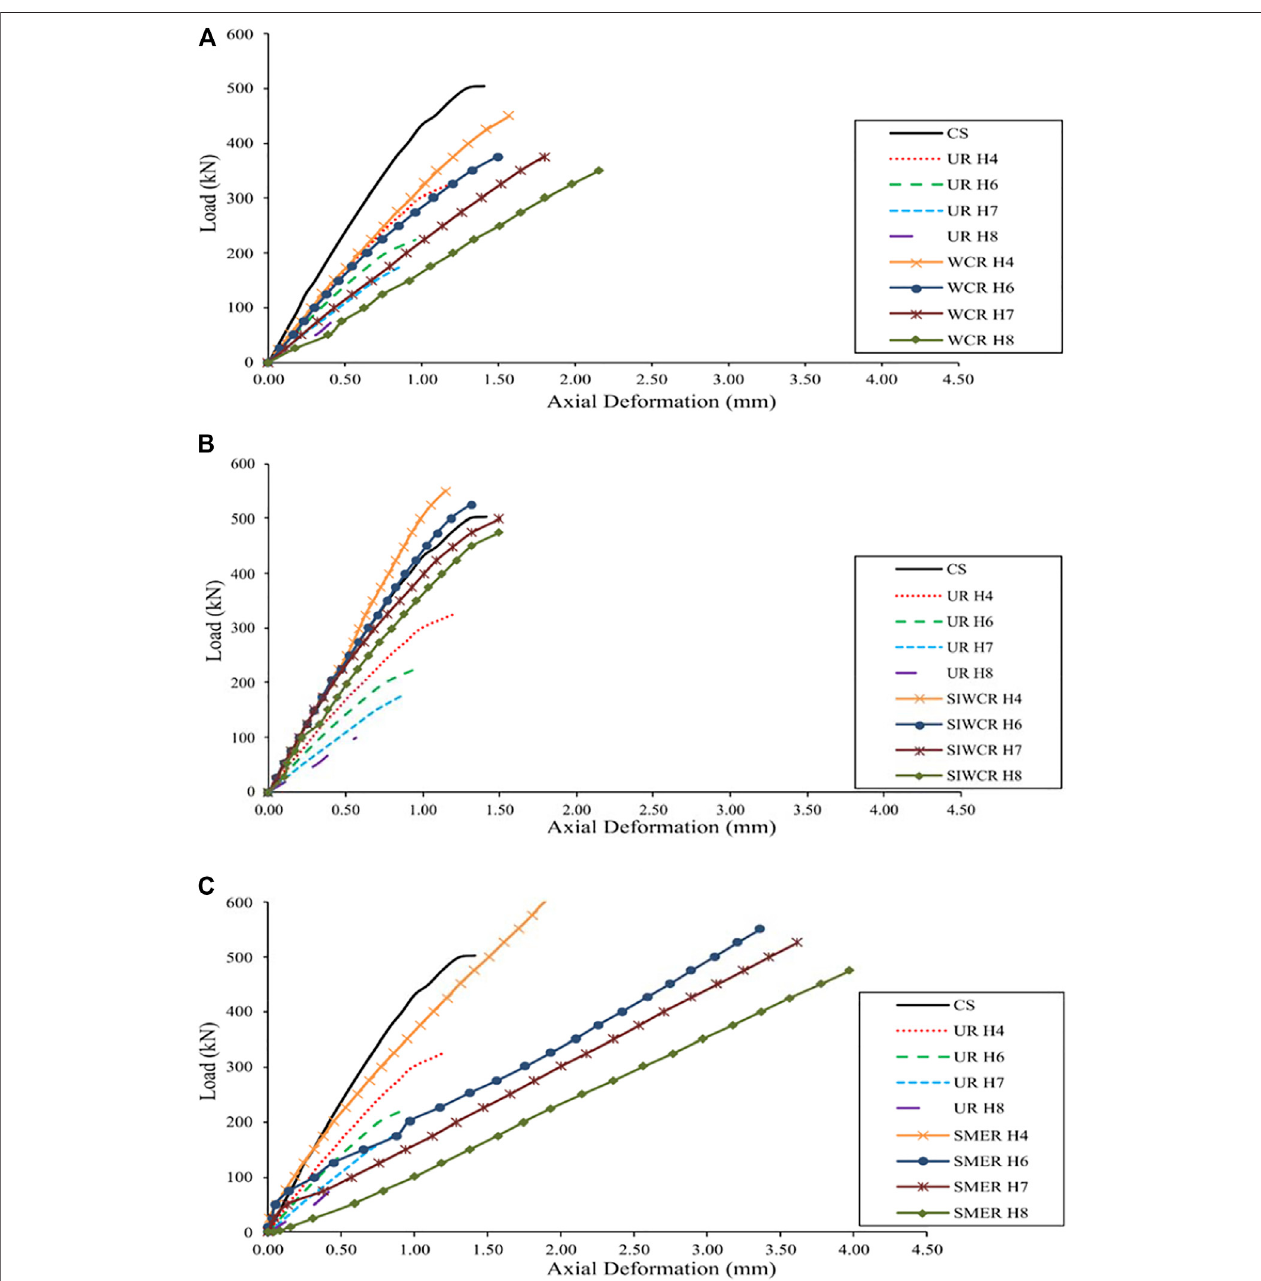
FIGURE10| Loaddeformationcurvesof (A) heated,unheated,andrepairedwithWCR (B) heated,unheated,andrepairedwithSIWCR (C) heated,unheated,and repaired with SMER.